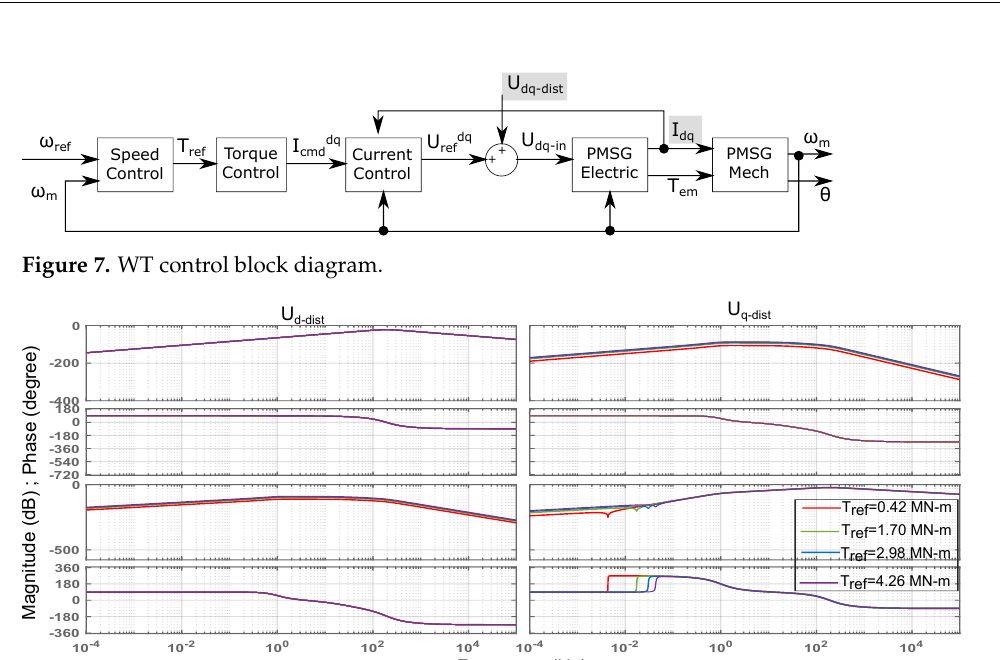
Figure 8. Admittance Y WT , dq with fixed ω m and variable